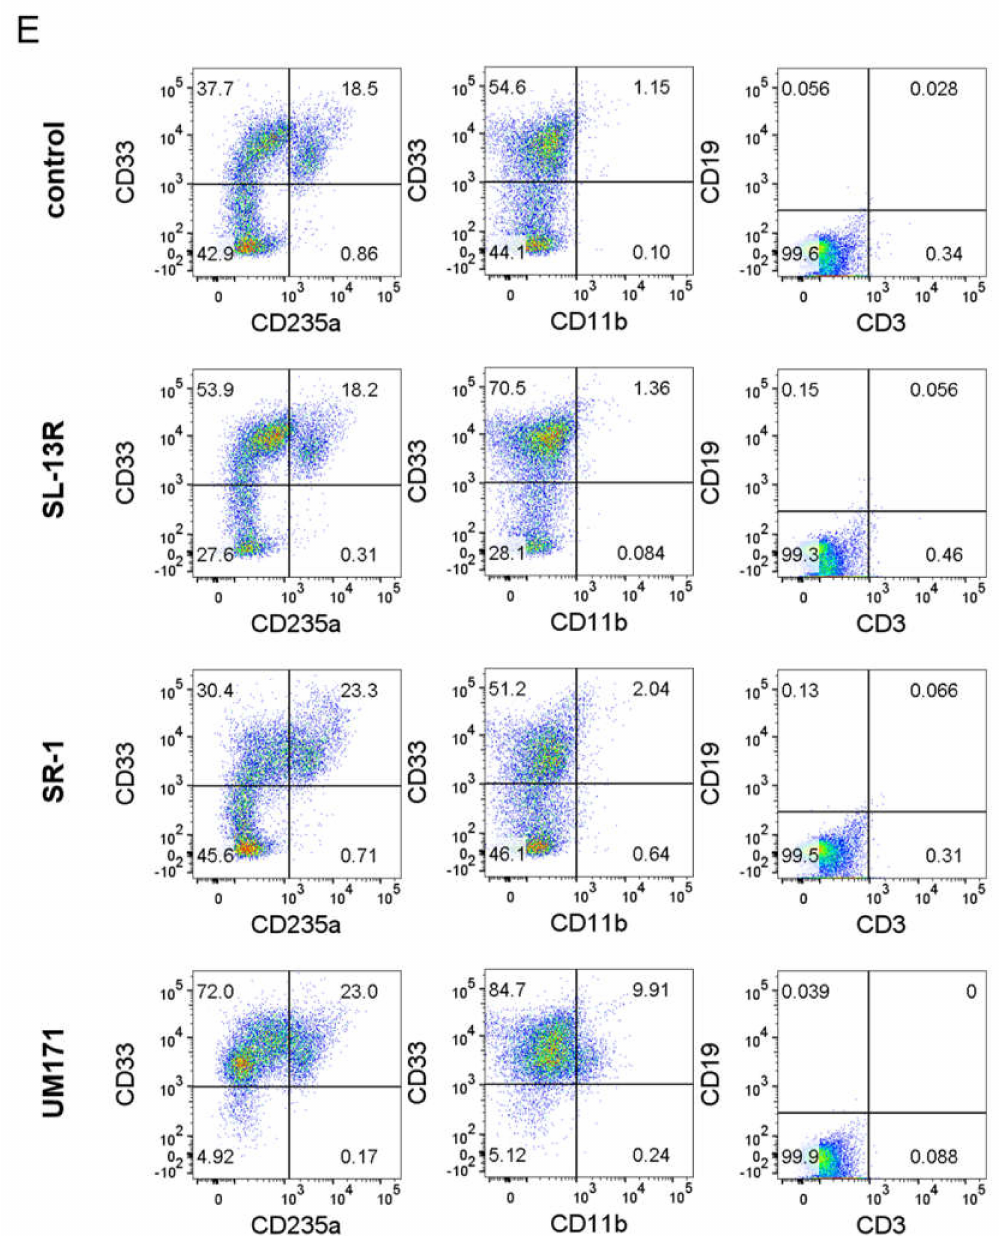
Figure 3. SL-13R expands HSPC number as potently as SR-1 and UM171. ( A ) The percentage of CD34+ cells cultured in the presence of SL-13R, SR-1, or UM171 for 7 and 14 days. ( B ) The number of live cells cultured in the presence of SL-13R, SR-1, or UM171 for 7 and 14 days. ( C ) The number of CD34+ cells cultured in the presence of SL-13R, SR-1, or UM171 for 7 and 14 days. ( D ) The number of HSCs (CD34 + CD38 − CD45RA − CD90 + CD49f + cells) in the presence of SL-13R, SR-1, or UM171 for 7 and 14 days. ( A – D ) n = 3; 3 UCB donors. The control was PBS treatment. One-way analysis of variance followed by Tukey’s post hoc test was used to test intergroup differences. ** p < 0.01, *** p < 0.005. ( E ) Percentages of CD33, CD235a, CD11b, CD19, and CD3 positive cells cultured in the presence of SL-13R, SR-1, or UM171 for 9